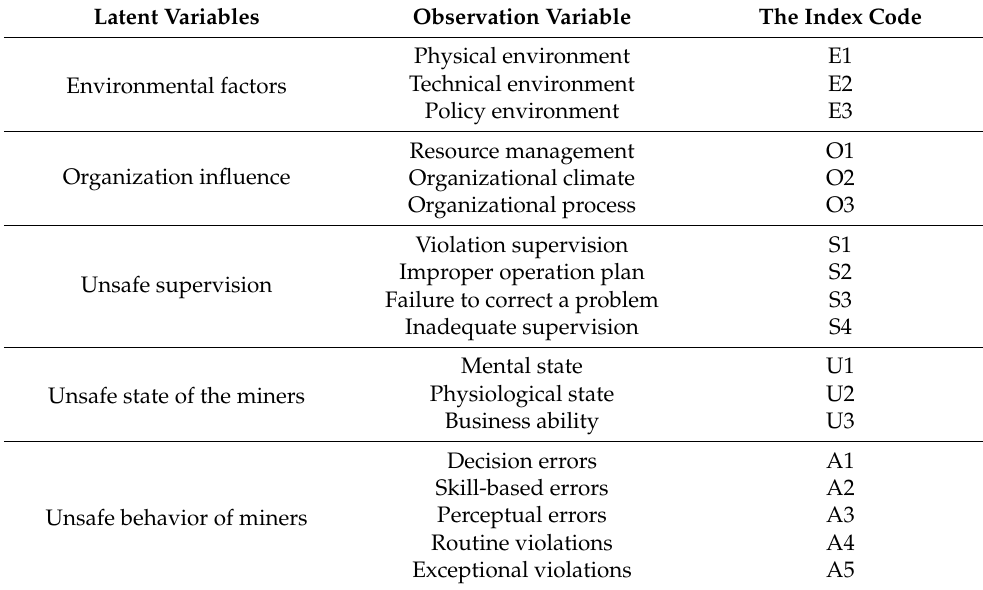
Table 1. Potential variables and observed variables in the initial SEM